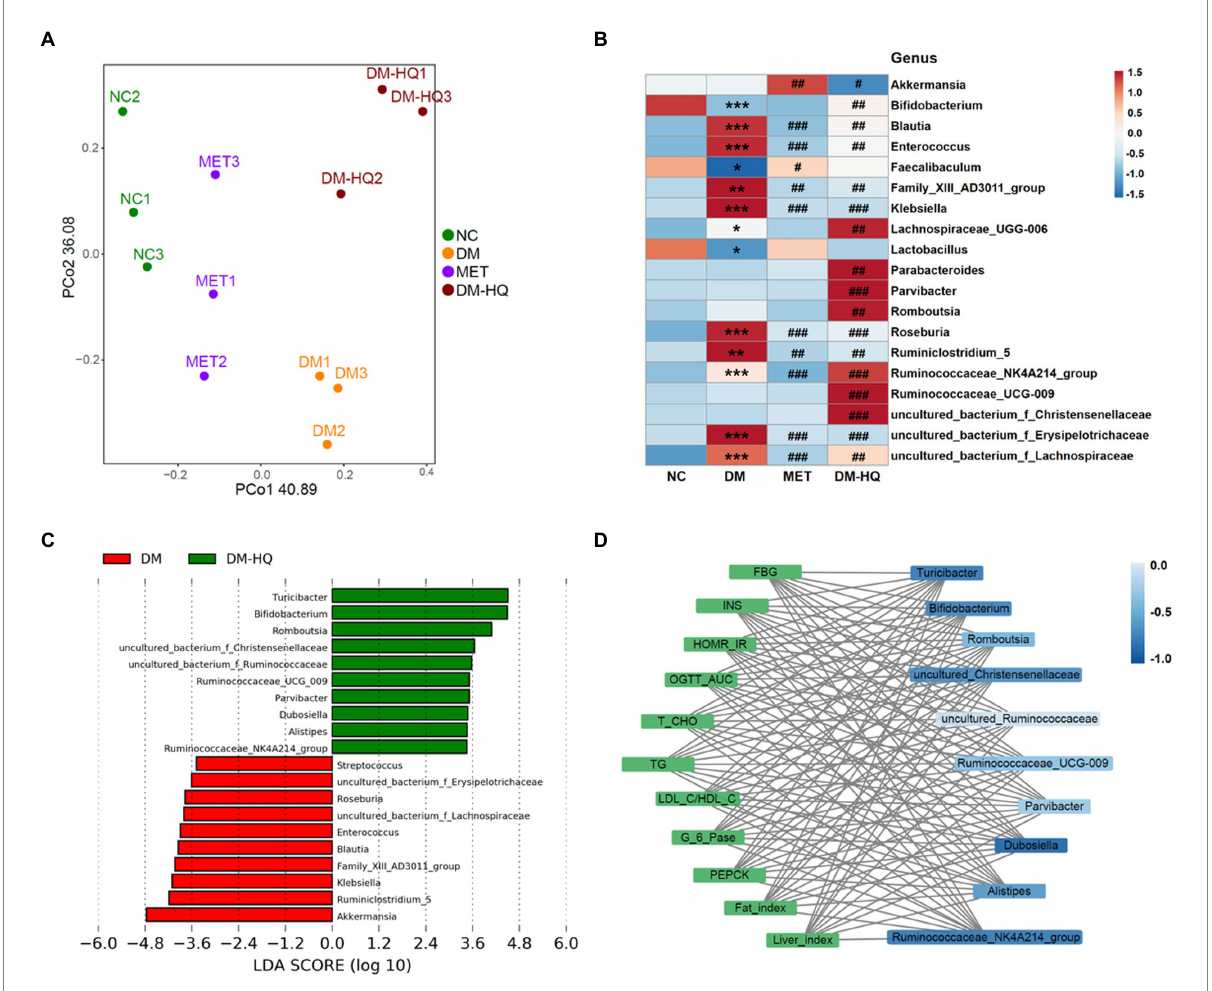
FIGURE 2 HQLHS regulated the intestinal flora disorder caused by type 2 diabetes. (A) Principal co-ordinates analysis (PCoA) of the cecal content microbiota. (B) Heat map statistics of significant difference genus. (C) Analysis of differences in the microbial taxa shown by [linear discriminant analysis (LDA; LEfSe) coupled with effect size measurements] between the DM group and the DM-HQ group (log10 LDA > 2.0). (D) Visualization of the correlation network between glycolipid parameters and dominant genus in the DM-HQ group based on Spearman’s rank correlation coefficient. Data are expressed as mean ± SEM. One-way ANOVA was used to analyze statistical differences; Compare to NC: * p < 0.05; ** p < 0.01; and *** p < 0.001; Compare to DM: # p < 0.05; ## p < 0.01; and ### p <